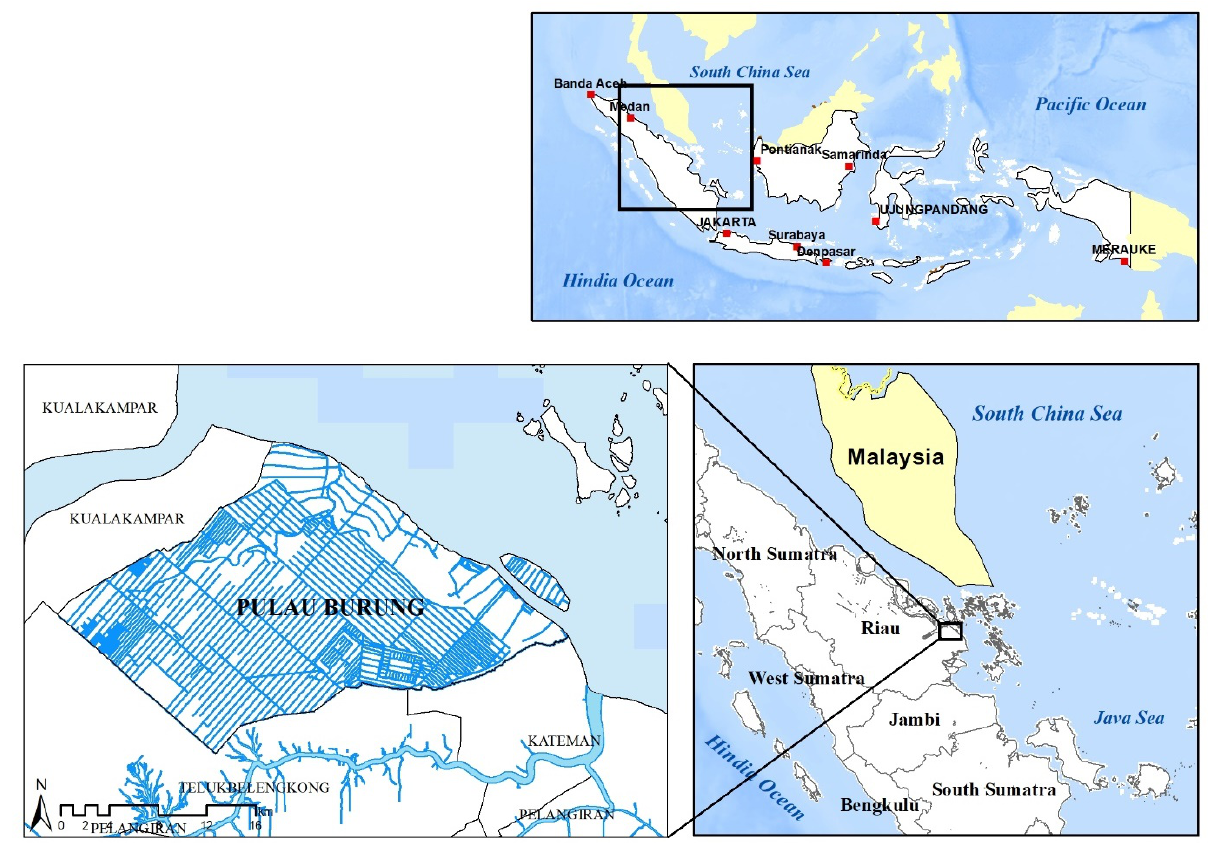
Figure 1. Map of the research location in Pulau Burung, Riau, Indonesia. The blue lines represent the canal network within the